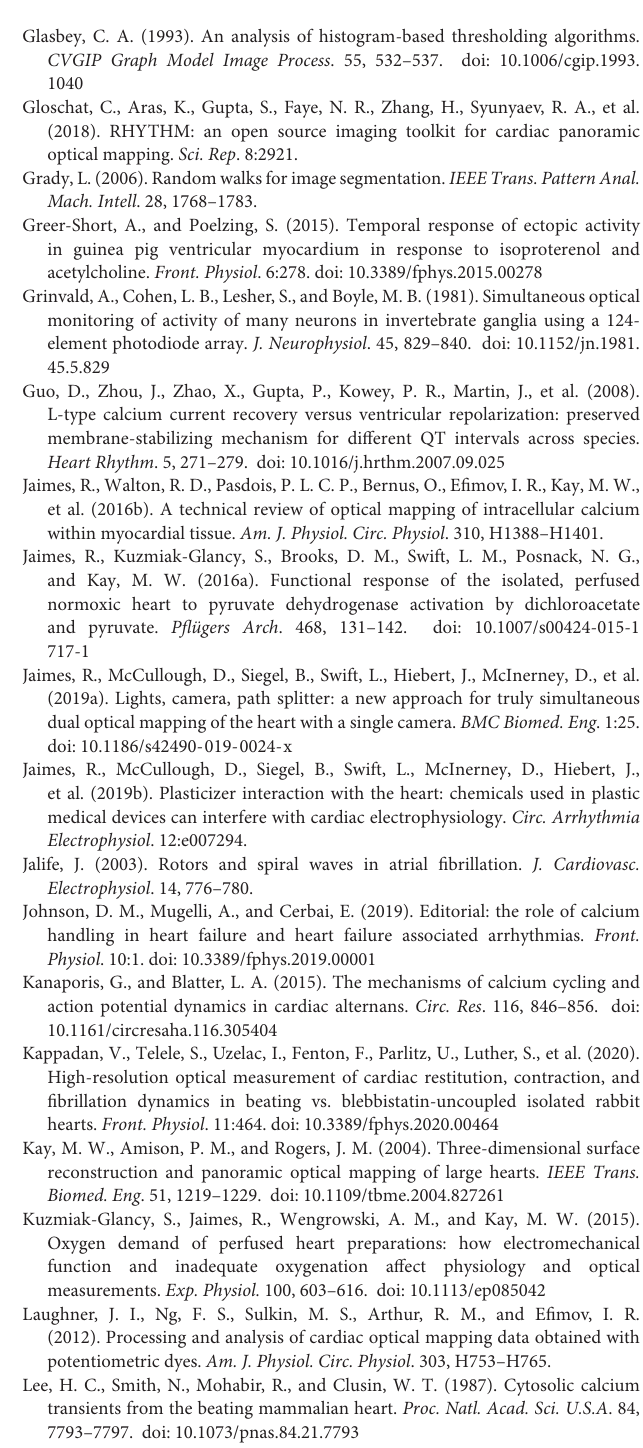
Supplementary Figure 1 | Example User Interface. Representative TIFF stack ( ∗ .tif) loaded into the KairoSight interface, with “Image Properties” including frame rate defined by the user. During “Processing,” background was removed, pixels were box blurred 3 × 3, 100 Hz filter was applied, signal drift was removed, and traces were normalized (0–1). During “Analysis,” the start and end of a signal upstroke was defined by the user to measure activation